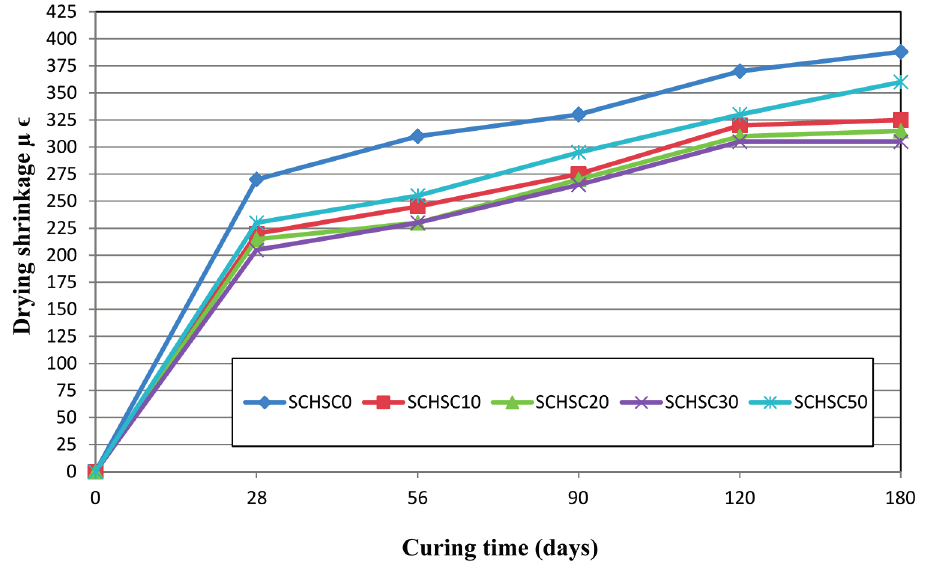
Figure 11. Development of drying shrinkage strain with